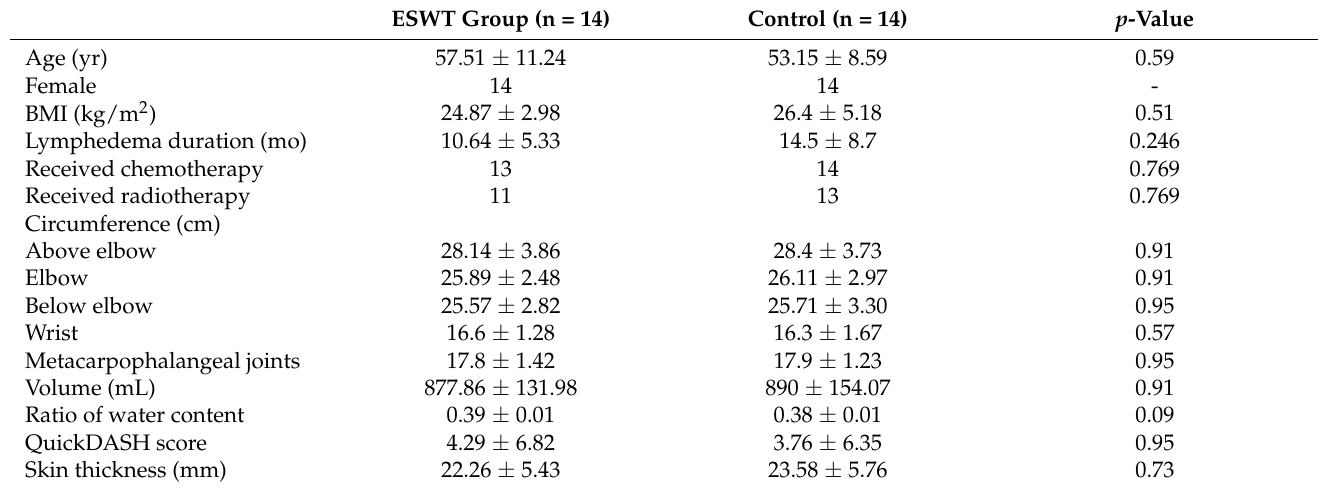
Table 1. Baseline characteristics of subjects.